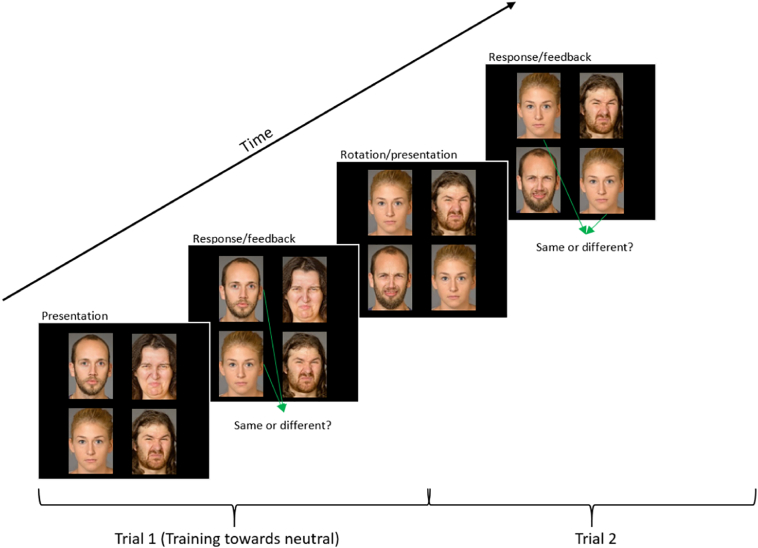
Example trial of a person-identity-matching task. Two pairs of faces were presented simultaneously, forming a 2 × 2 grid of 4 faces. Each pair consisted of two individuals, one displaying a neutral expression and the other expressing disgust. In the neutral variant of this PIM task, participants were instructed to ignore the faces with a disgusted expression and only pay attention to the neutral faces in order to identify whether the two neutral faces belonged to the same individual (identity match). The participants used the controller joystick to respond by pushing it left for ‘yes/same’ and right for ‘no/different’. If the participants responded correctly, the background of the VR environment would flash green, whereas if they responded incorrectly it would flash red. A new trial began with the top pair of faces rotating out of the grid, the bottom pair rotating to the top, and a new pair of faces appearing at the bottom.